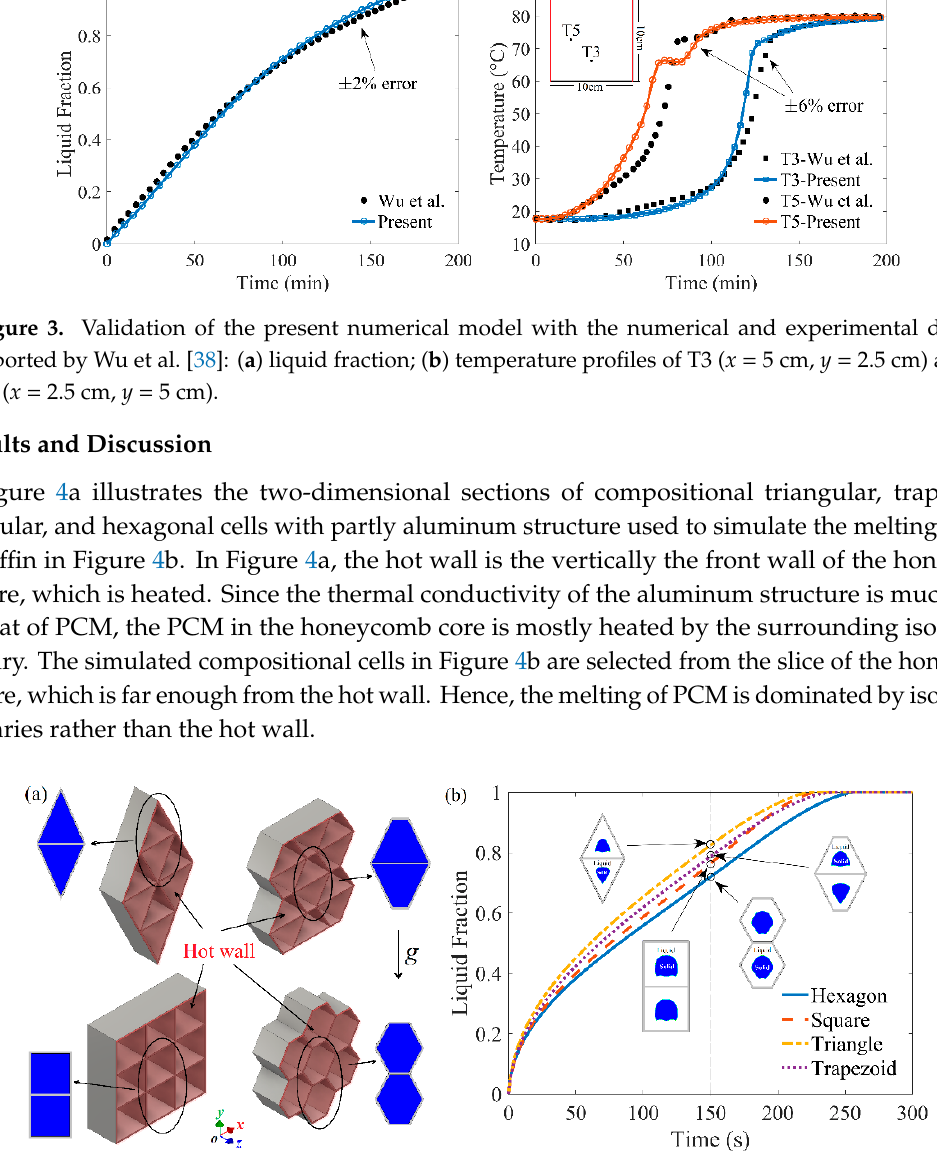
Figure 4. ( a ) Sketch of 2D cross-sections of triangular, trapezoidal, square, and hexagonal cells and ( b ) liquid fractions of the triangular, trapezoidal, square, and hexagonal honeycomb cores.